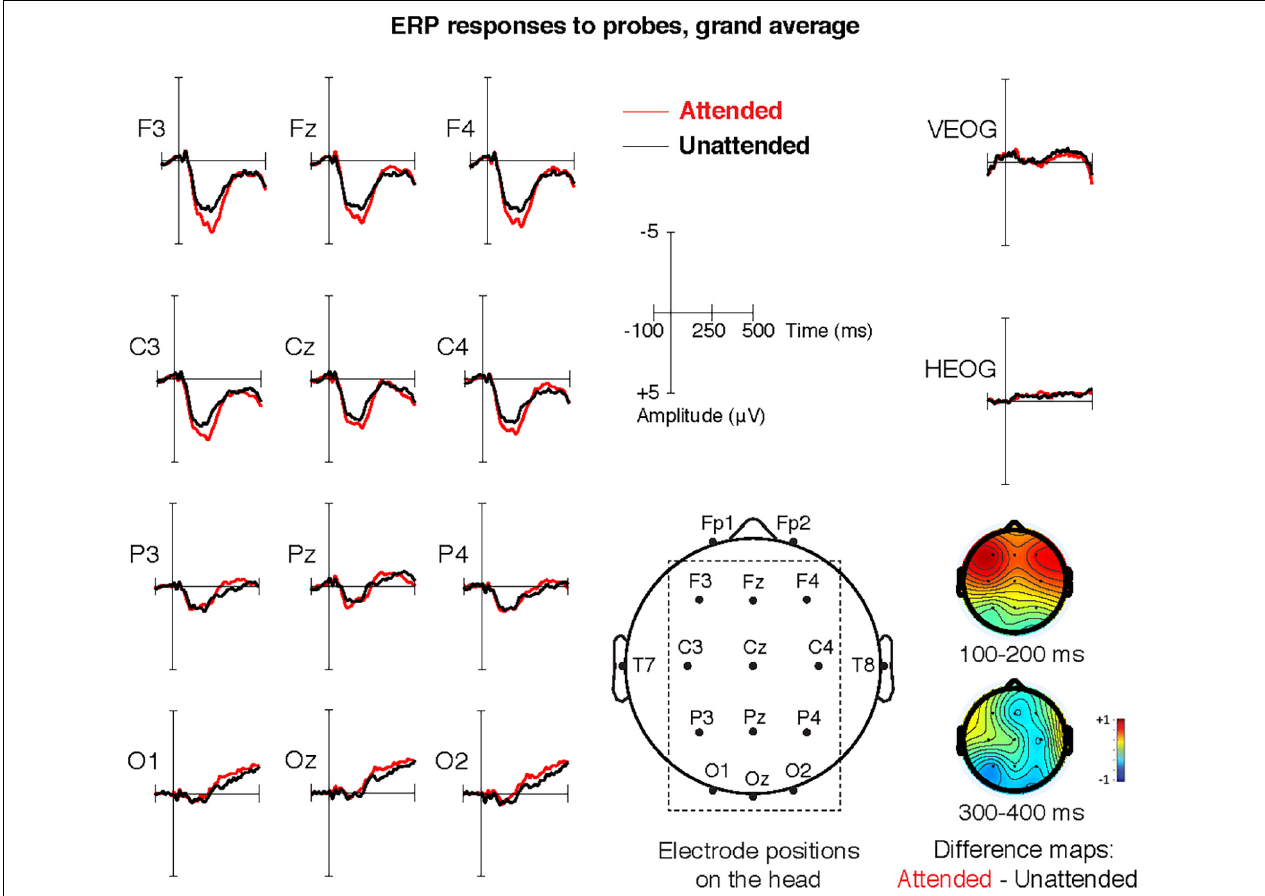
FIGURE 2 | Grand average ERP responses to probes in the attended and unattended channel and electrode placement in Swedish AudAt. Topographic maps show differences in amplitude between attended and unattended in the early and the late time window